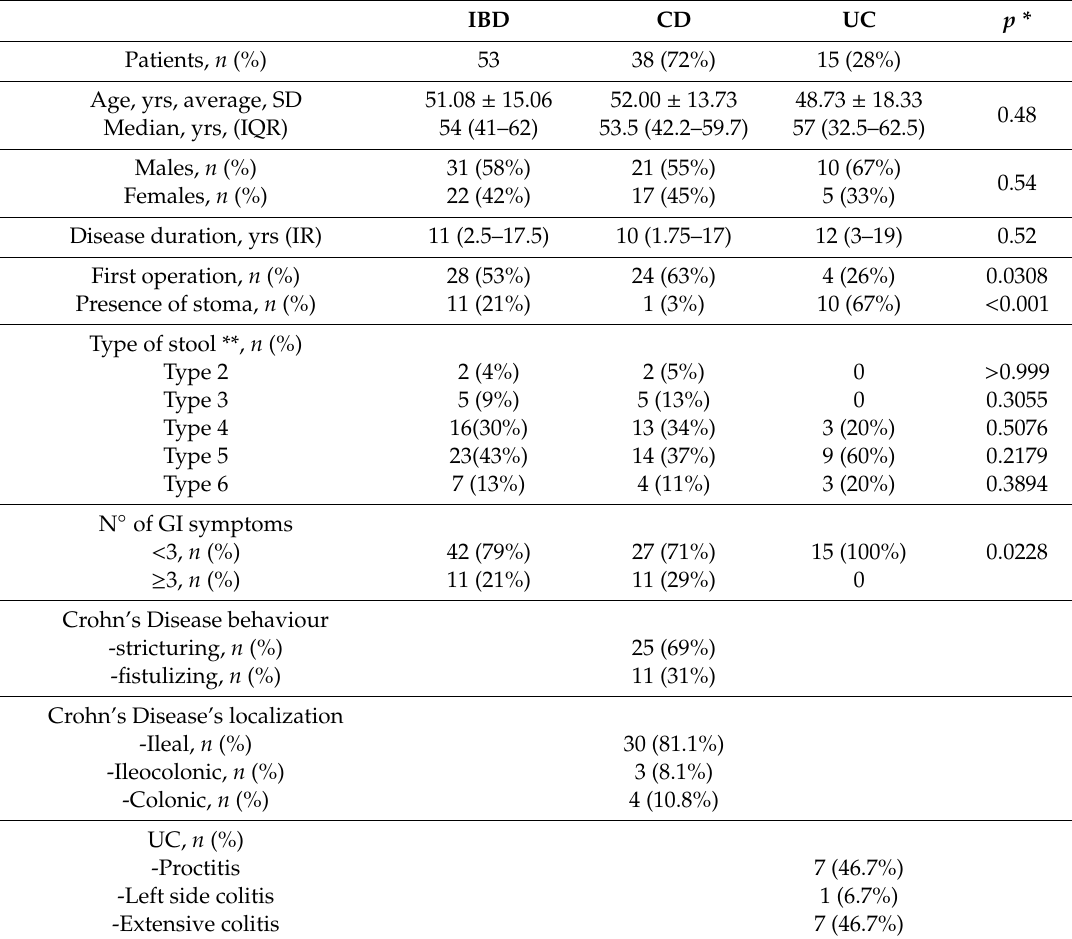
Table 2. Baseline characteristics of Inflammatory Bowel Disease (IBD)